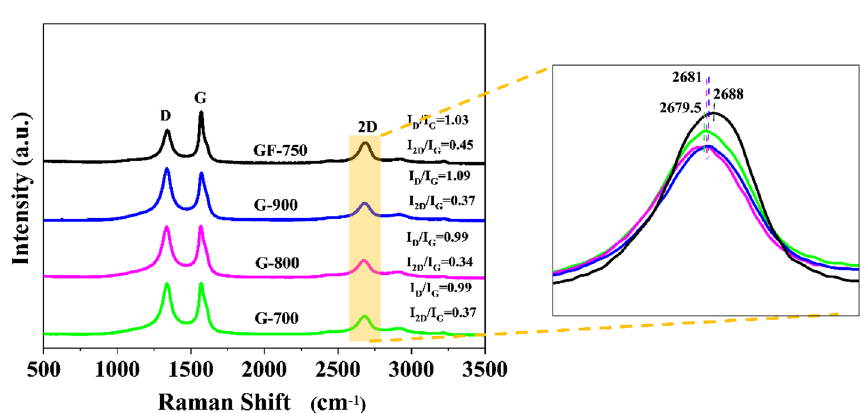
Figure 3. Raman spectra of graphene-based electrode